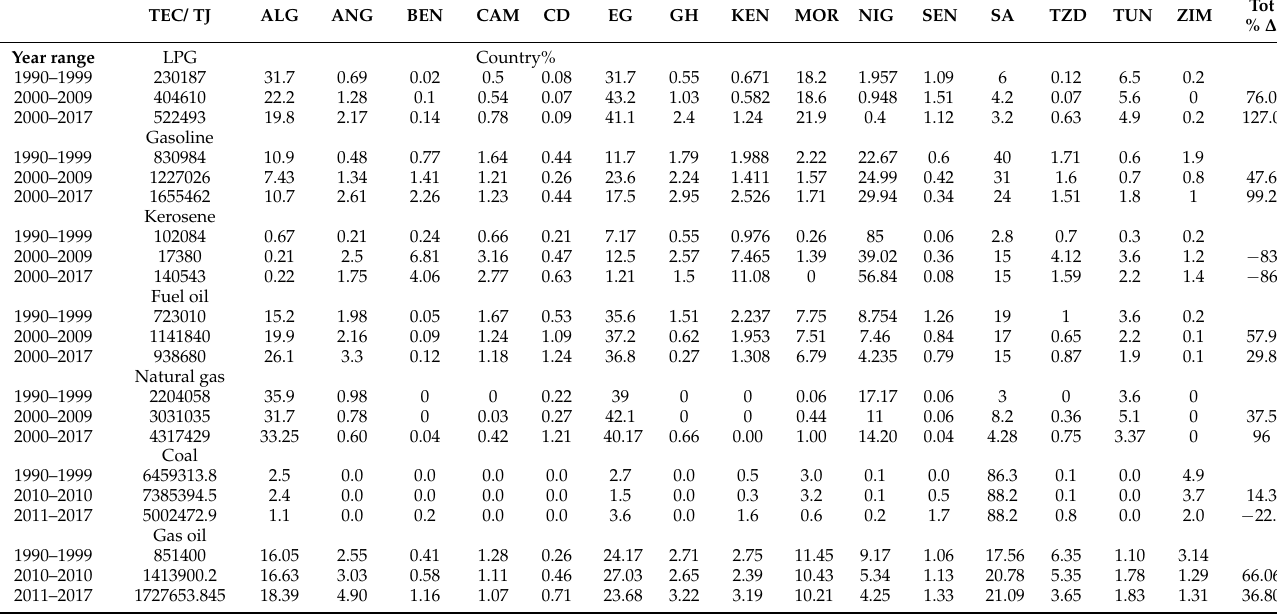
Table A2. Non-renewable energy consumption from different